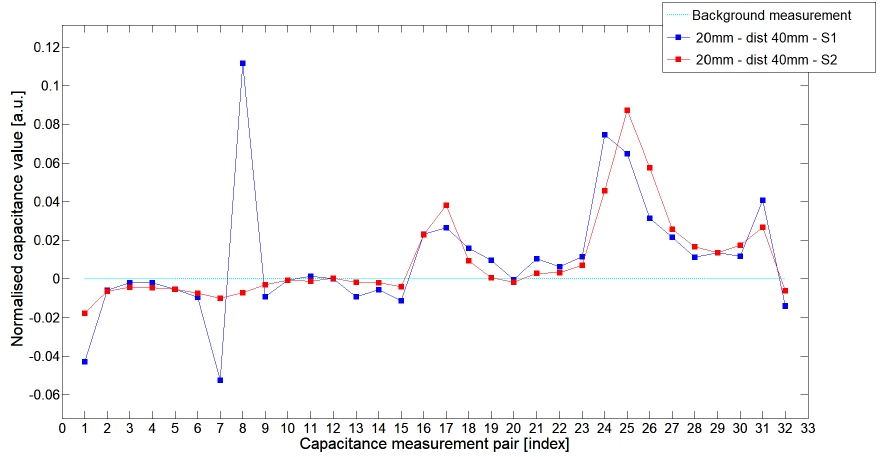
Figure 16. The 1st electrode measurement cycle (S1: 1->32 and S2: 1->32) for Test20 P 2 and S1—blue line, S2—red line. Cyan line indicates lower calibration